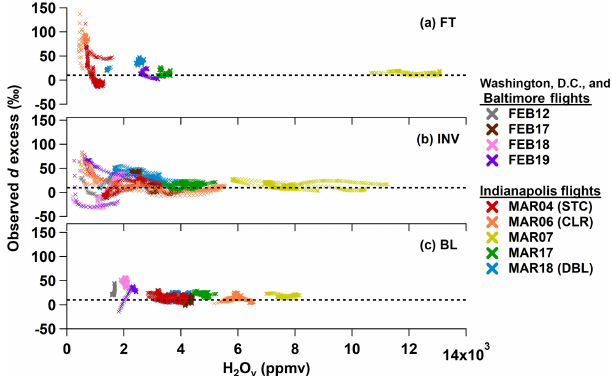
Figure 4. Observations of d excess versus H 2 O v mole fraction in the (a) free troposphere (FT), (b) inversion (INV), and (c) bound- ary layer (BL) during all the VP descents. Colors indicate each re- search flight. BL, INV, and FT observations are defined by the rate of change of atmospheric variables. The dashed lines correspond to the global average precipitation d -excess value of 10‰ for refer- ence